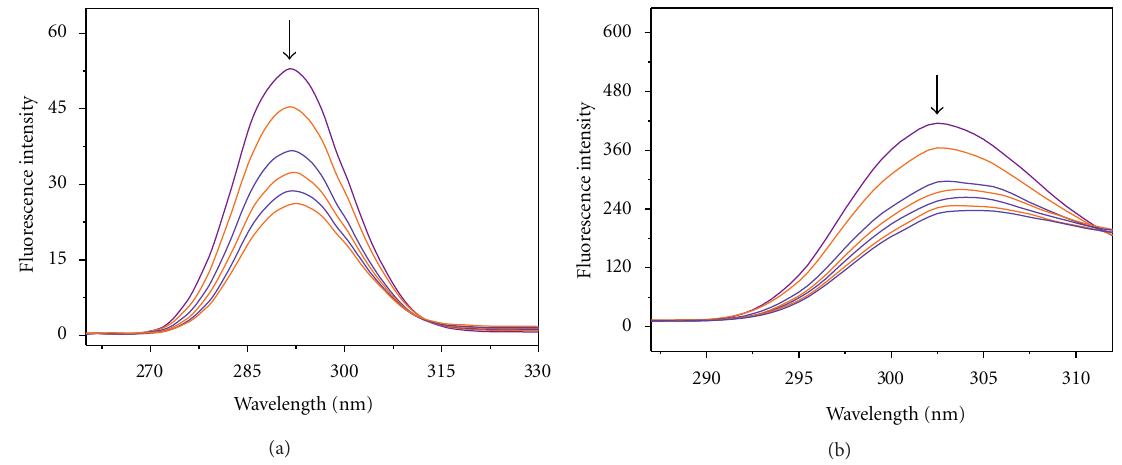
F 3: Synchronous �uorescence spectra of BSA with various amounts of Evo, (a)